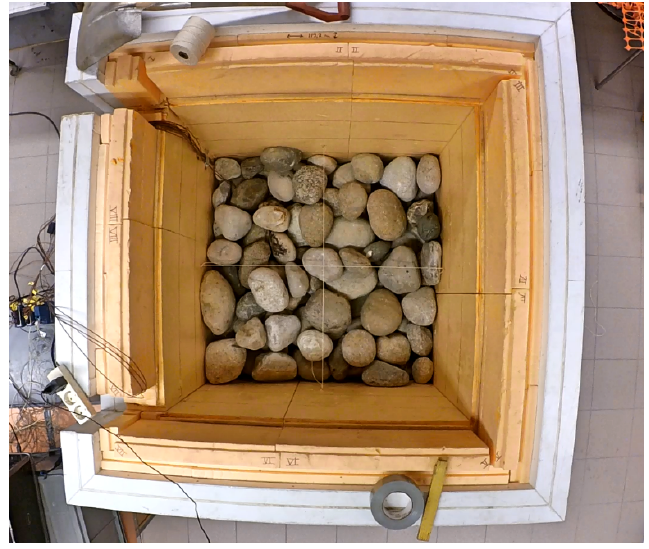
Figure 13. Test sample in preparation phase (Rieksts et al., 2017 [27]).